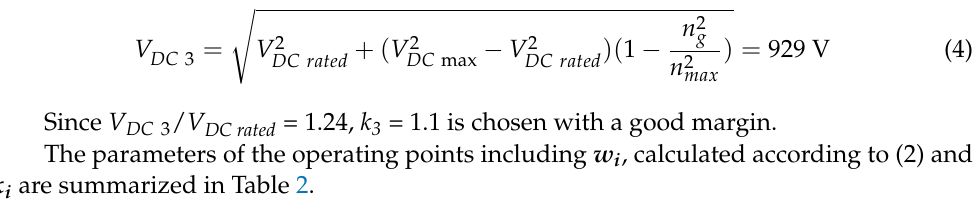
Table 2. Operating points of the traction motor considered during the